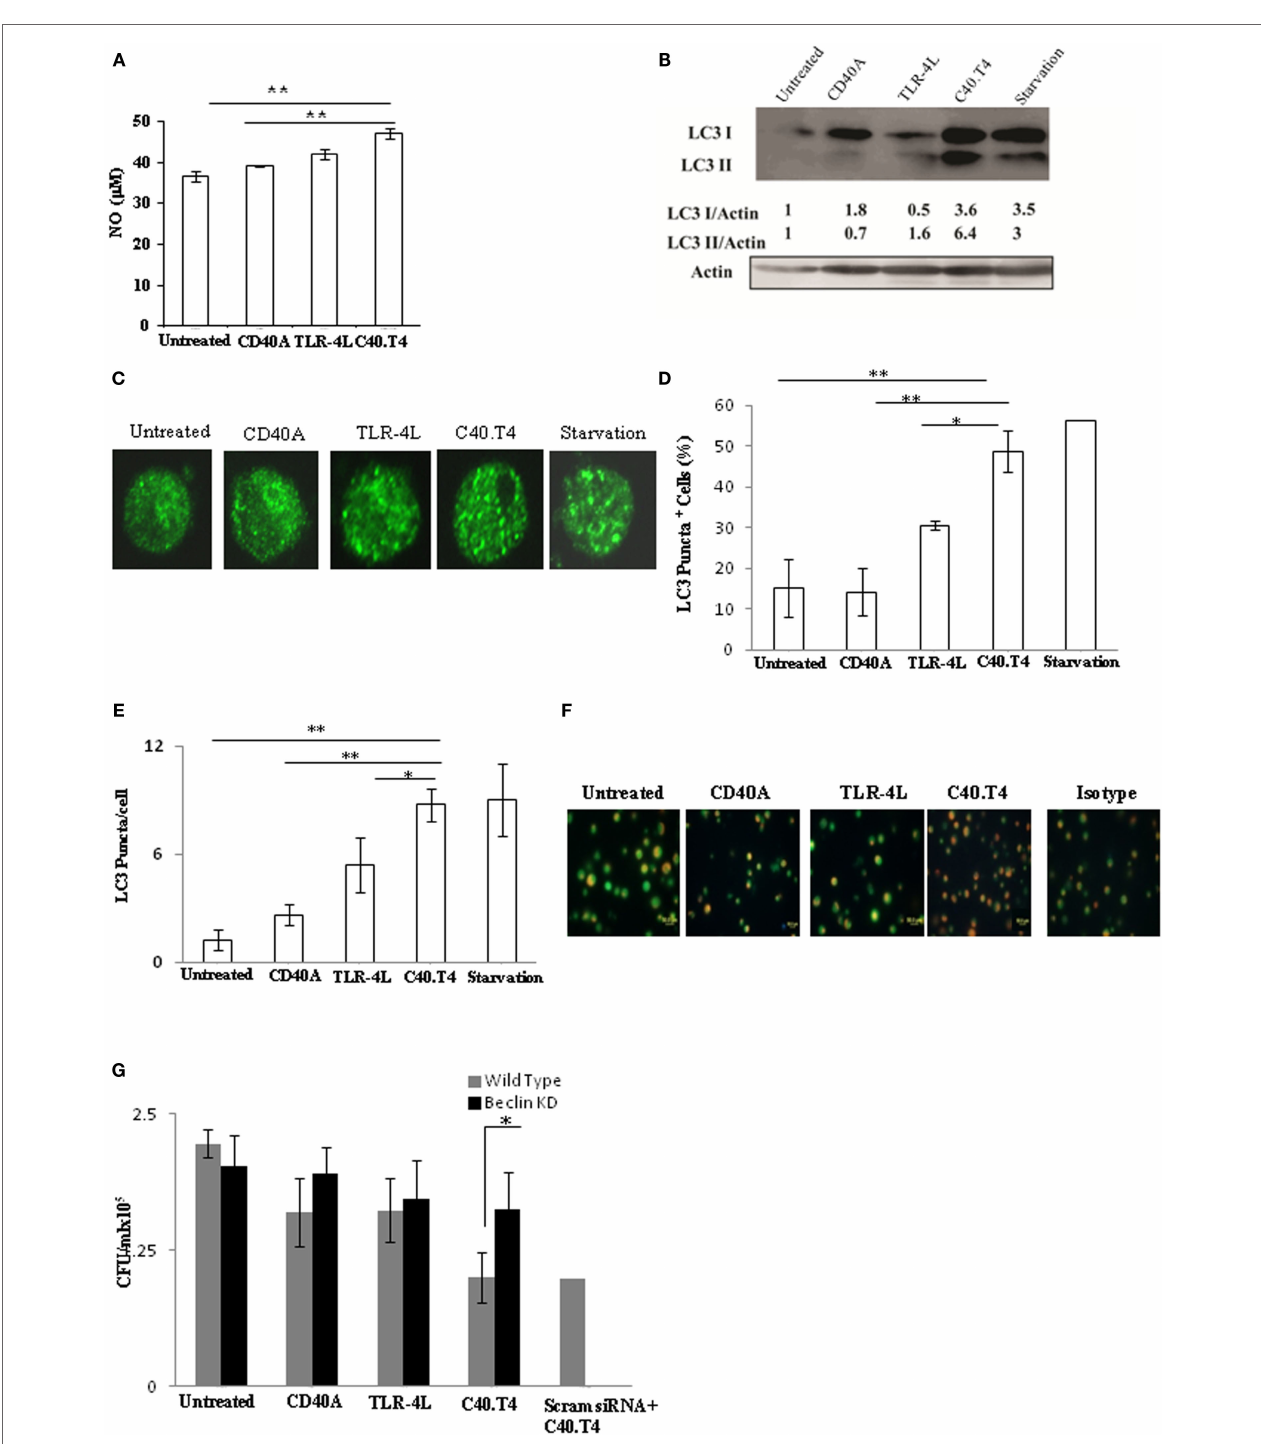
FigUre 6 | Triggering through c40.T4 showed augmentation in autophagy . DCs infected with Mtb were stimulated through C40.T4, CD40, TLR-4 for 24 h and assessed for (a) NO in SNs by Greiss assay. (B) Expression of LC3 was detected in the whole cells lysates of DCs stimulated for 2 h through C40.T4 by immunoblotting. Actin was used as a loading control. Densitometric data show the LC3I/actin and LC3II/actin ratio. (c) LC3 puncta formation was demonstrated by immunofluorescence staining. Starved DCs were used as a positive control; (D,e) Bar graphs depict the percentage of LC3 puncta positive cells and LC3 puncta per cells, respectively. (F) DCs were stimulated through C40.T4 for 5 h were later incubated with acridine orange for 15 min to visualize autophagosomes by fluorescence microscopy (40 × ). Orange dots indicate the acidic vacuoles. (g) Beclin KD DCs were infected with Mtb followed by stimulation with C40.T4. Later, cells were lysed and bacterial burden was quantified by CFU assay. Data represented as the mean ± SD (a,D,e,g) ; immunoblotting (B) ; fluorescent microscopy (c,F) ; are of 2–3 independent experiments. “*” and “**” indicate p < 0.05 and p < 0.01,